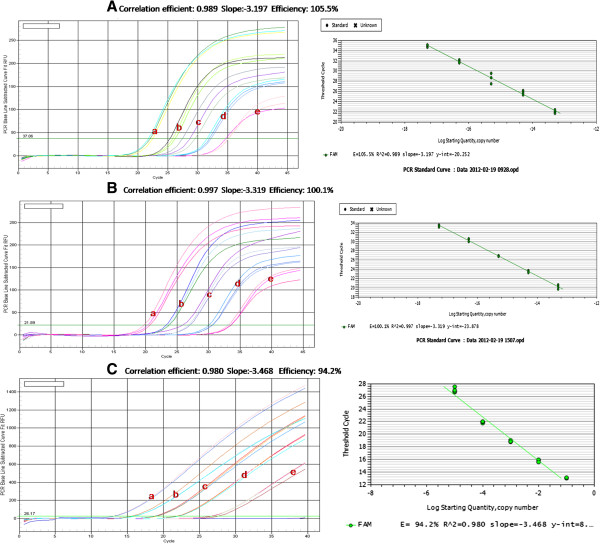
Standard curve for TaqMan real time RT-PCR amplification of standard ssRNA (viral transcripts): A: Amplification plots showing the testing in triplicate of a 10-fold dilution series containing standard ssRNA of WYMV at: 2x105(a); 2x104(b); 2x103 (c); 2x102(d); 2x101(e) template copies per reaction. B: Amplification plots showing the testing in triplicate of a 10-fold dilution series containing standard ssRNA of WYMV at: 1x106(a); 1x105(b); 1x104 (c); 1x103(d); 1x102(e) template copies per reaction. C: Amplification plots showing the testing in triplicate of a 10-fold dilution series containing standard ssRNA of WYMV at: 2x105(a); 2x104(b); 2x103 (c); 2x102(d); 2x101(e) template copies per reaction.